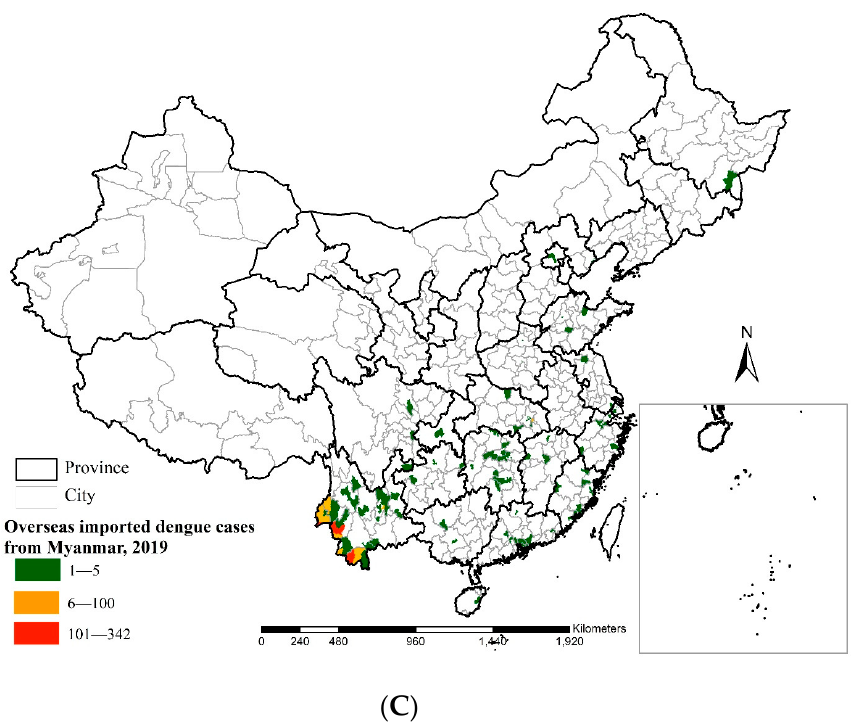
Figure 6. Spatial distribution of overseas imported dengue cases in mainland China in 2019. ( A ). All overseas imported cases. ( B ). Cases from Cambodia. ( C ). Cases from Myanmar.